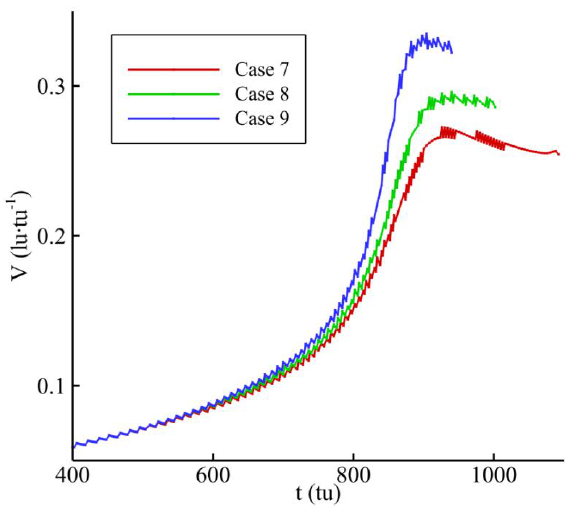
Figure 15. The evolution of micro-jet in Cases 7–9.